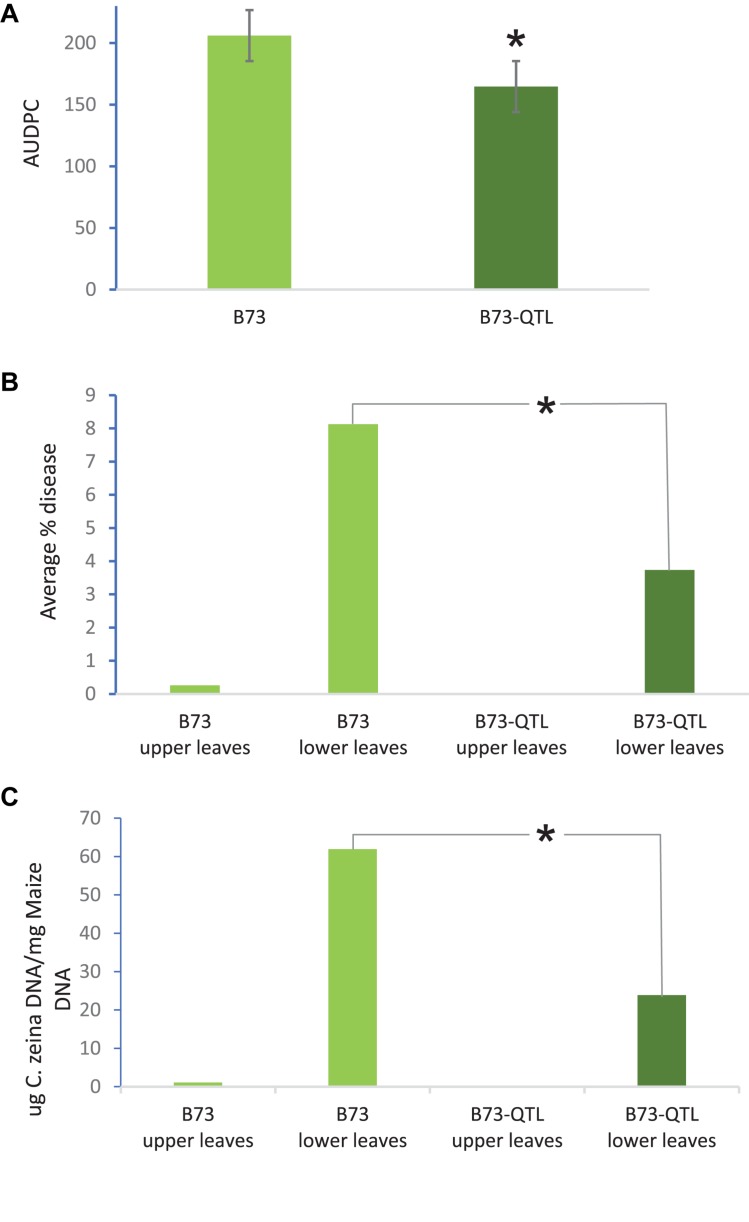
B73-QTL plants have lower GLS disease severity in the field than B73 plants. (A) Area under disease progress curve of GLS scores for B73 and B73-QTL maize lines. (B) Quantification of C. zeina gDNA content (as a proxy for fungal load) between B73 and B73-QTL upper and lower leaves. Fungal load was below the threshold for B73-QTL upper leaves. (C) Quantification of GLS disease lesion area between B73 and B73-QTL upper and lower leaves by digital image analysis. Lesion areas were below the quantification threshold for B73-QTL upper leaves. All panels: *significant difference (Student’s t-test, p < 0.05) between B73 lower leaves and B73-QTL lower leaves. Error bars represent standard errors.